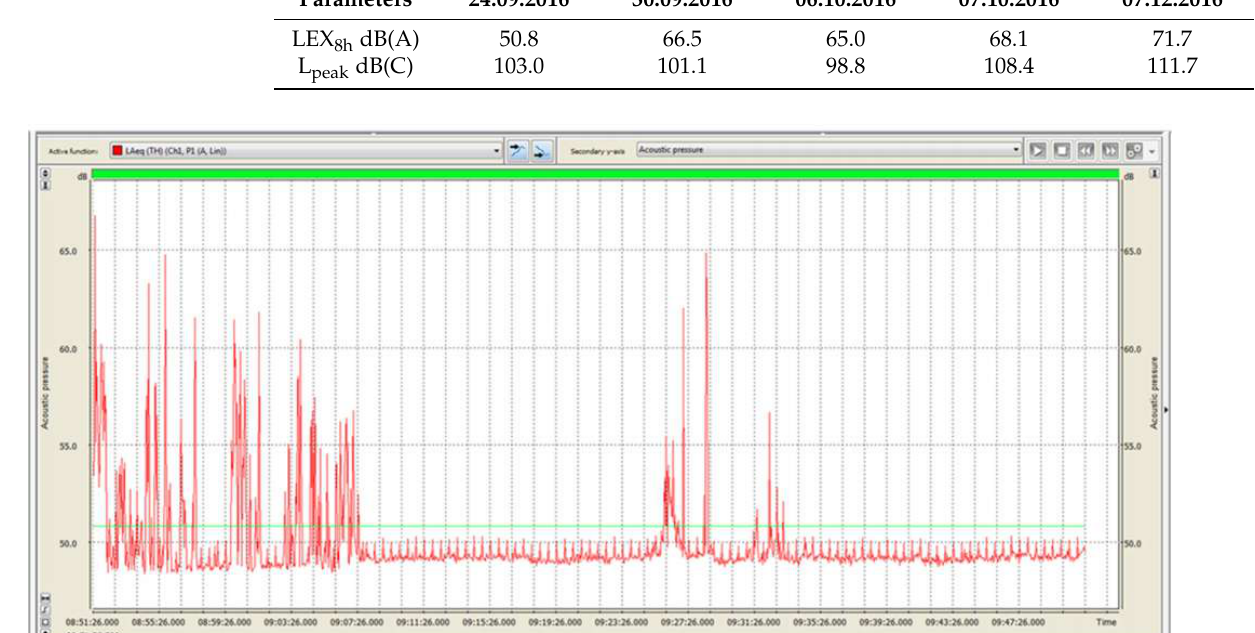
Figure 2. 24.09.2016. Acoustic emissions in dissection room, detected in activity-free intervals with functioning air conditioning system. Red line: level during T period of 15” (Leg), expressed as dB (A). Green line: equivalent sound level during the entire monitoring period (Leg), expressed as dB (A).